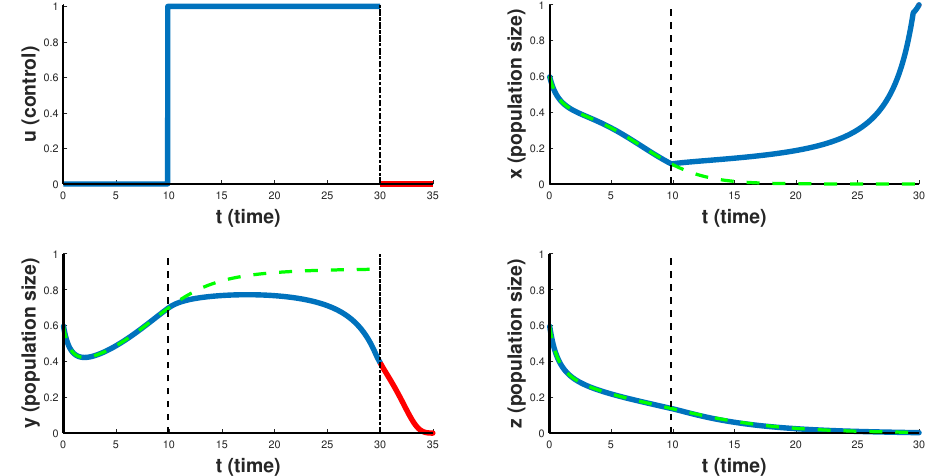
Figure 4. The optimal solutions x ∗ ( t ) , y ∗ ( t ) , z ∗ ( t ) and optimal control u ∗ ( t ) for the values of the parameters r = 0.6, p = 1.1, q = 1.0, η = 1.2, γ = 0.8, α 1 = 1.2, α 2 = 0.9, α 3 = 0.9, β 1 = 0.6, β 2 = 0.75, β 3 = 1.3, m = 0.4, µ = 100, u max = 1, T = 30 and the initial conditions x 0 = 0.6, y 0 = 0.6, z 0 =